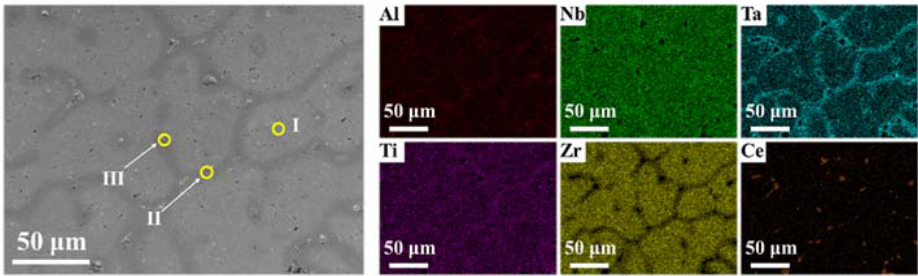
Figure 3. SEM and corresponding EDS images of Ce5: Region I: intra ‐ dendrite region; Region II: inter ‐ dendritic region and Region III: Ce ‐ rich region. Table 1. Element distribution in different regions in SEM images.